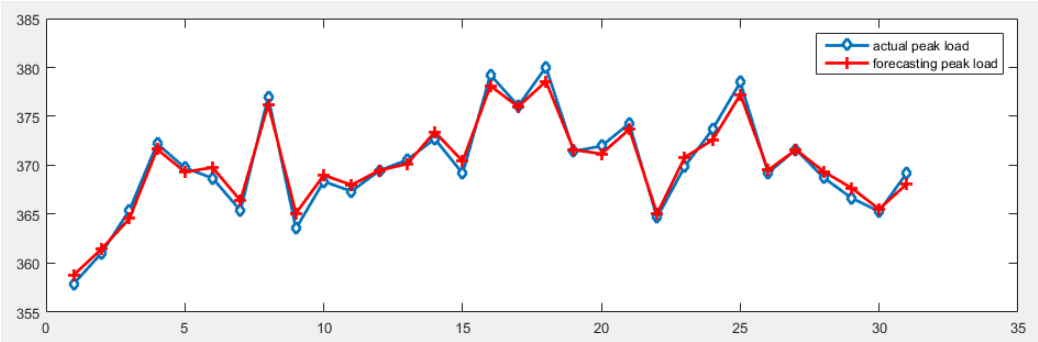
Figure 7. Figure of the final forecasting result (Unit: 10 MW).